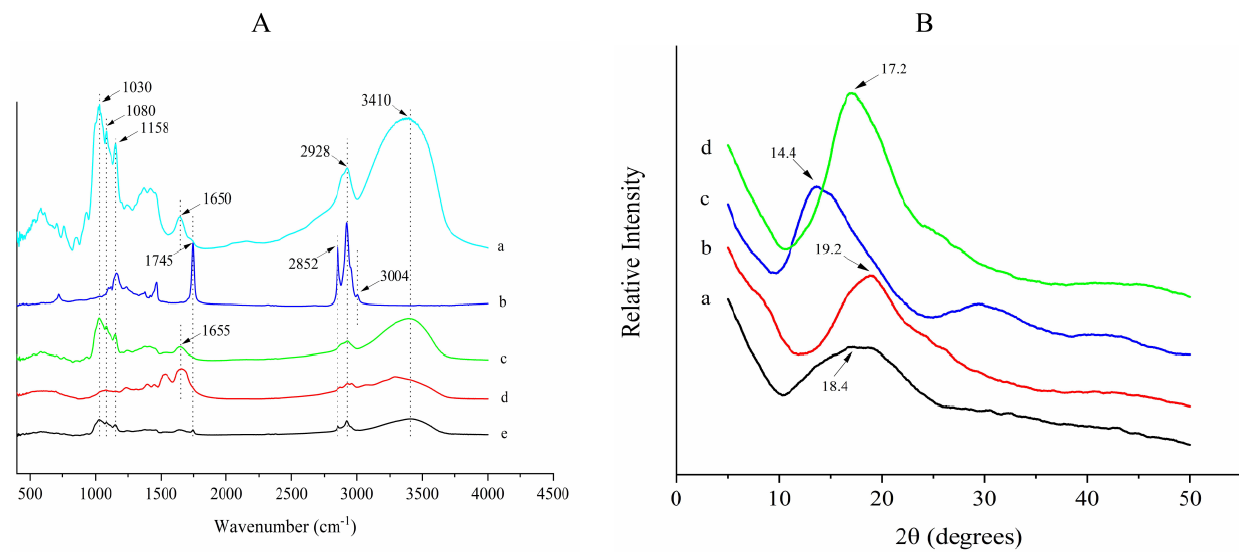
Figure 2. Fourier transformed infrared spectrometer spectra ( A ) of KGM (a), GLO (b), KGM/SPI wall (c) SPI (d) and GLOM (e), and X-ray diffraction patterns ( B ) of KGM (a), SPI (b), KGM/SPI wall (c) and GLOM (d).